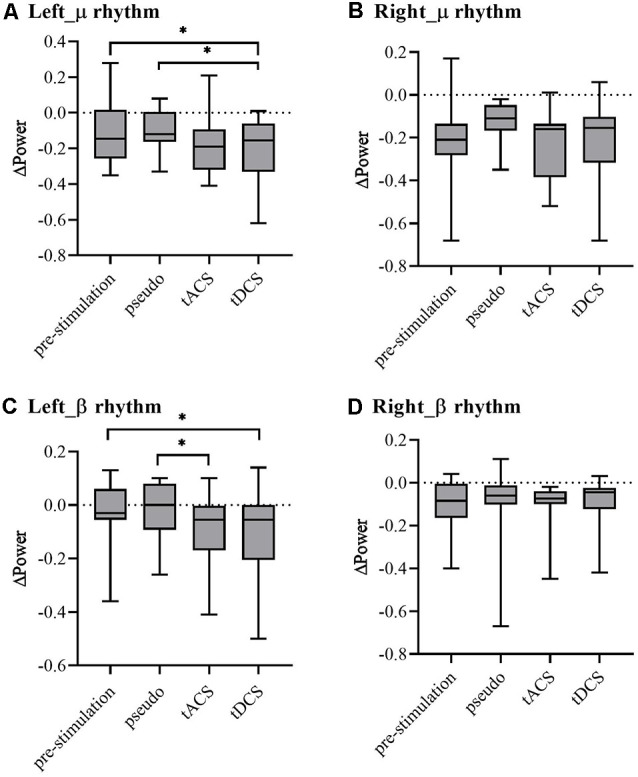
The ΔPower spectrum of each group (Note: ΔPower is the difference of ipsilateral and contralateral sides). (A) μ rhythm of the left-hand task, (B) μ rhythm of the right-hand task, (C) β rhythm of the left-hand task, and (D) β rhythm of the right-hand task. * represents significance P < 0.05.